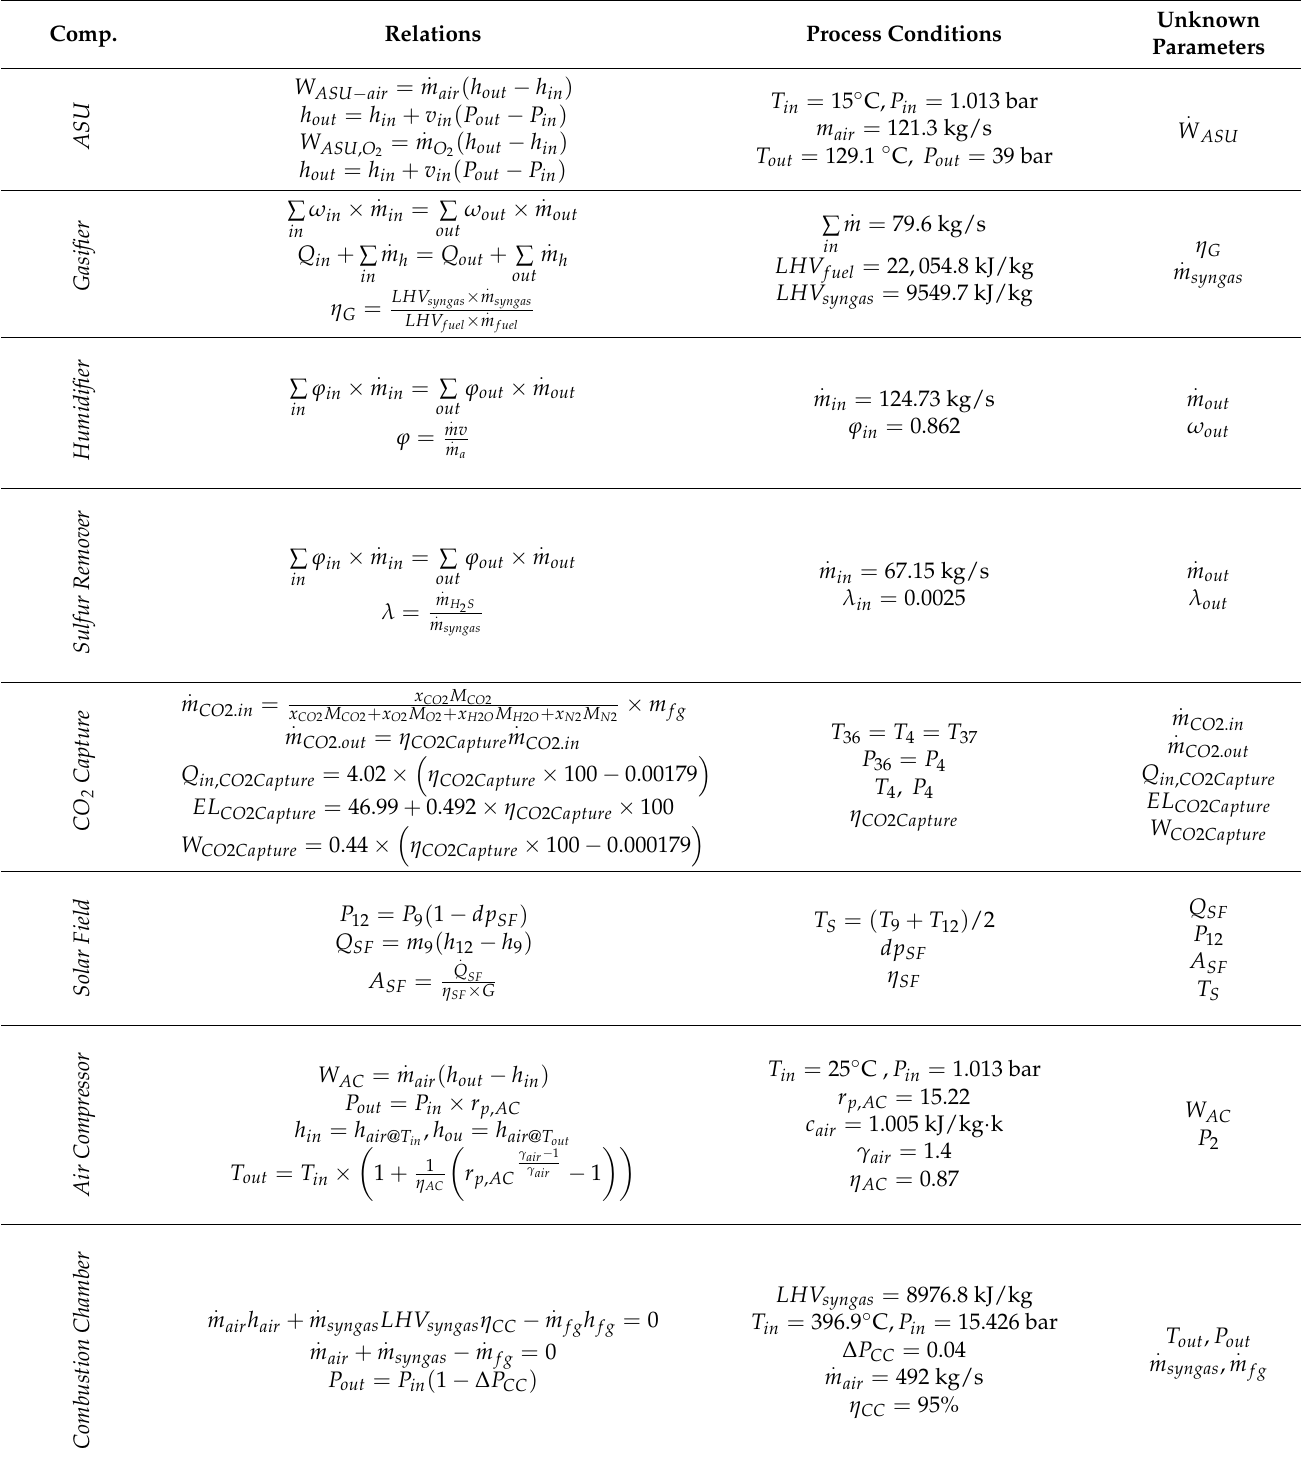
Table A1. Thermodynamic relations: process operating conditions and unknown parameters used for modelling the different ISGC system